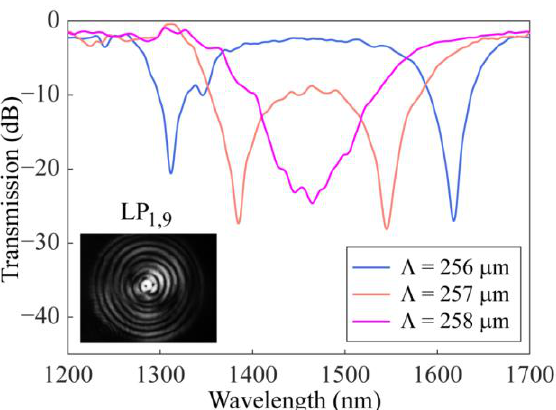
Figure 13. The experimental transmission spectra of the SMF-HLPGs with different grating periods. Inset shows the mode field distribution.